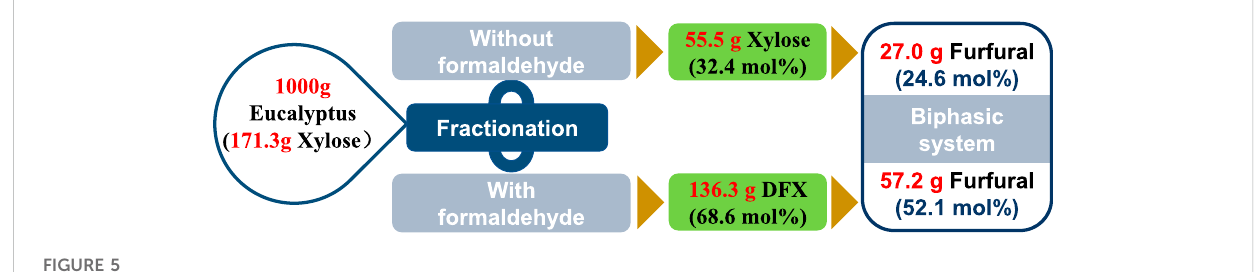
Comparsion of fractionation without or with formaldehyde addition for furfural